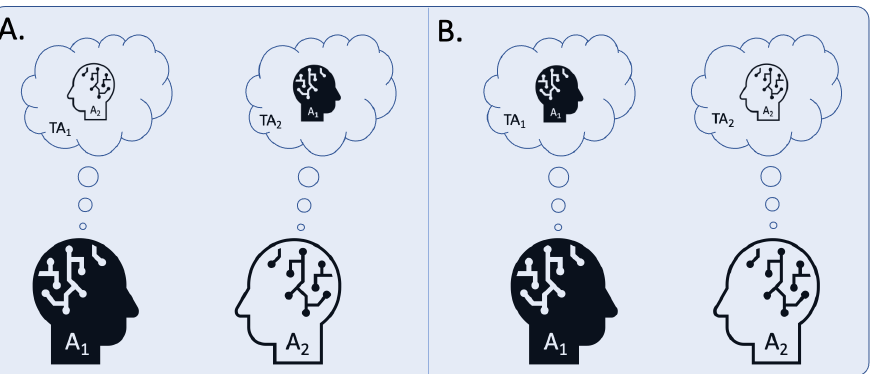
Figure 2. ( A ) both agents A 1 and A 2 have a representation of the other agent’s cognition (ToM). ( B ) both agents have a representation of their own cognition (introspection). TA i is a cognitive space (see, for example, [15,16]) in which the ‘thoughts of agent i ’